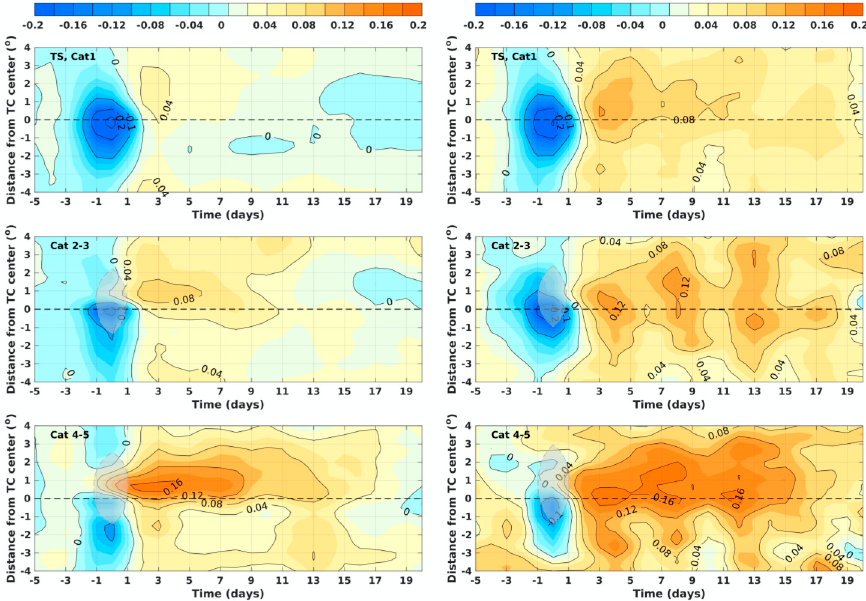
Figure 9. Along-track averaged composite of SSS anomaly (psu) relative to the reference SSS for different intensity categories (TS to Category 1, Category 2–3 and Category 4–5) using SMAP (left panels) and SMOS (right panels) swath daily data. Both the SMAP and SMOS SSS under high surface wind speed are removed. The gray shading indicates the region where more than 30% of the SSS pixels are removed. The y-axis is the cross-track ± 4 ◦ to the right and left of the track. Composite SSS response along track ± 4 ◦ to the center is averaged from days − 5 to 20.